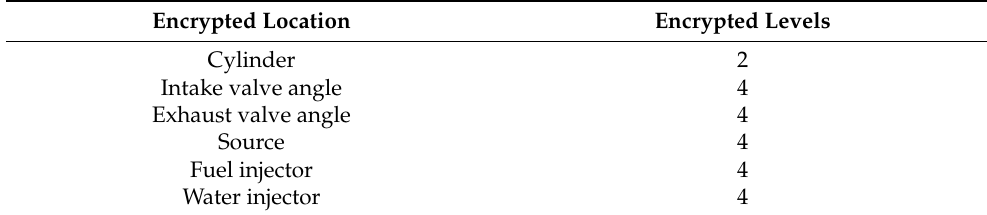
Table 5. Setting of encryption level of the GDI